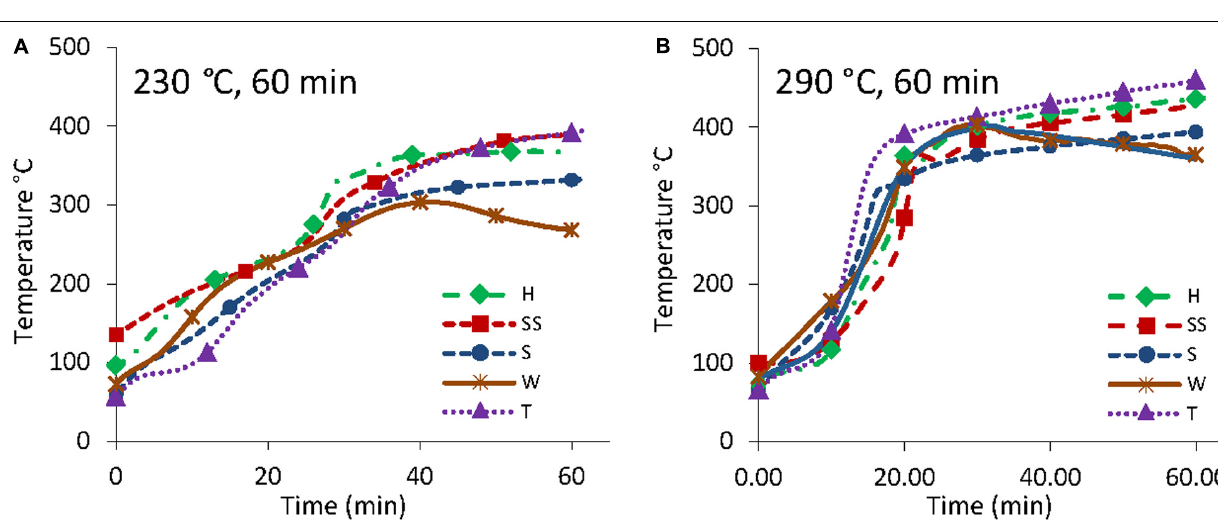
FIGURE 3 | Temperature profiles of biomass (H, hard almond shell; SS, semi soft almond shell; S, soft almond shell; T, almond twigs; W, walnut shell) during torrefaction at 230 ◦ C (A) and 290 ◦ C (B)